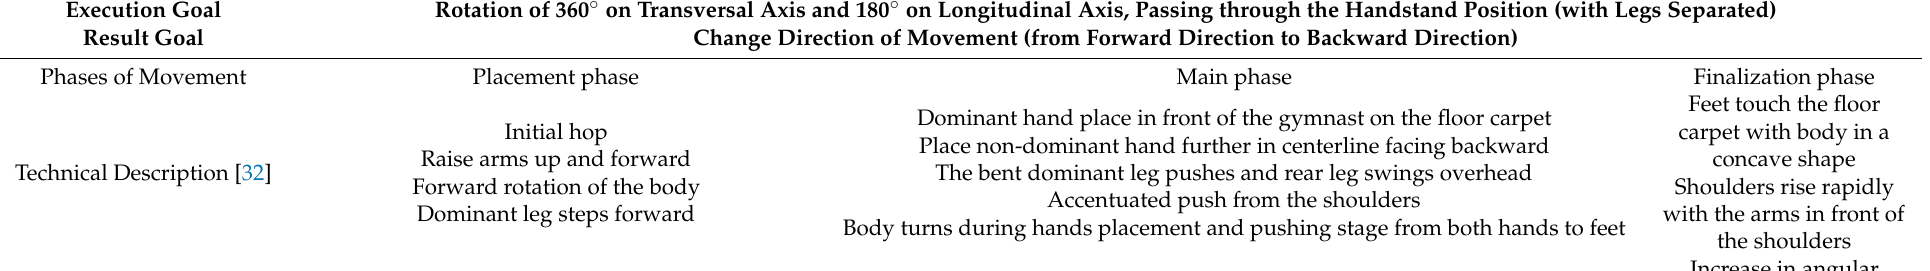
Table A2. Description of round off: goals, phases of movement, technical description, mechanical actions, segments angles and frames of